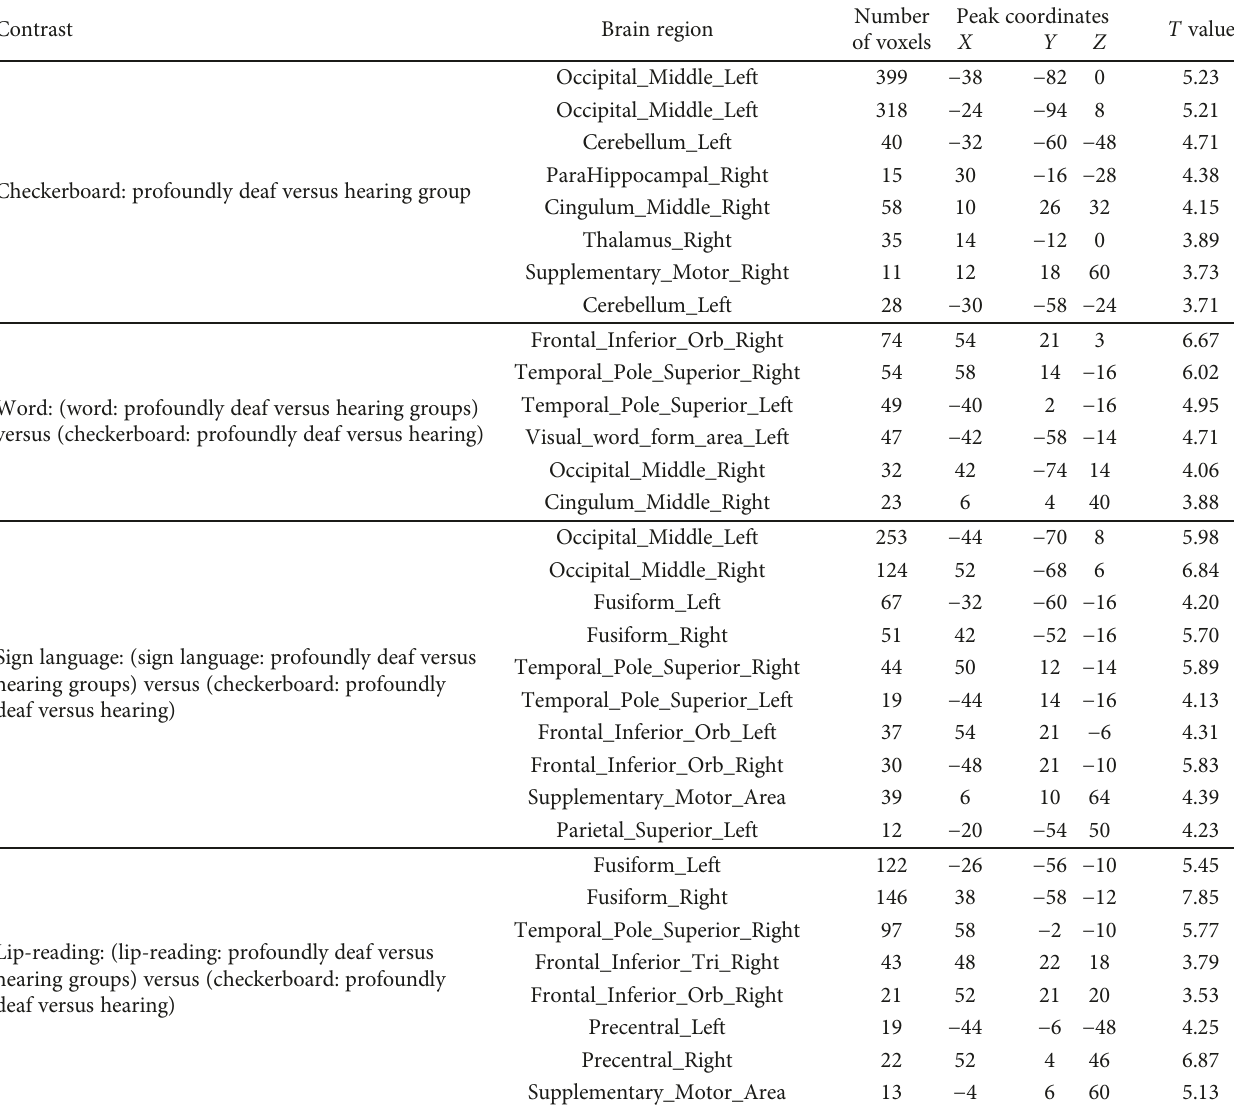
Table 4: Di ff erence in functional connections with the right STC as a seed region. Contrast Brain